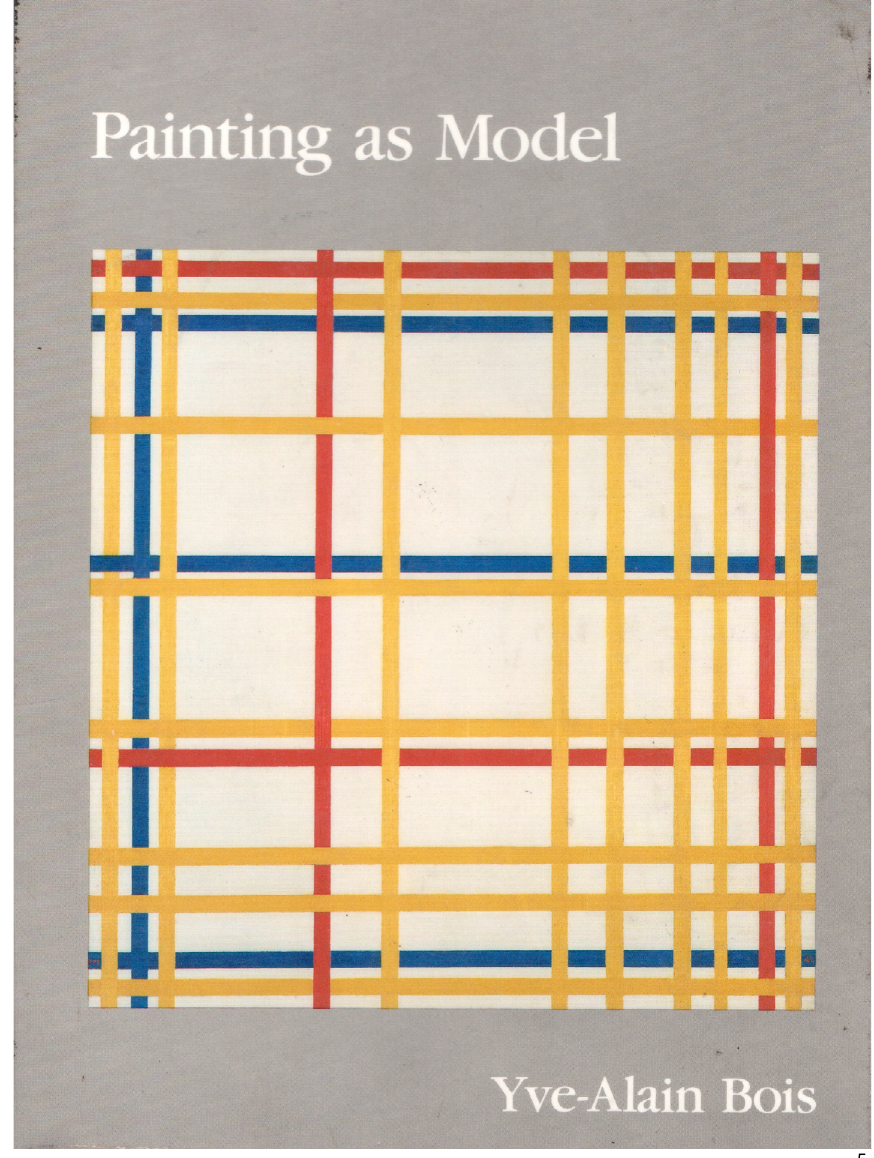
Front cover of the book Painting as Model by Yve- Alain Bois, 1990. Photo by Rixt